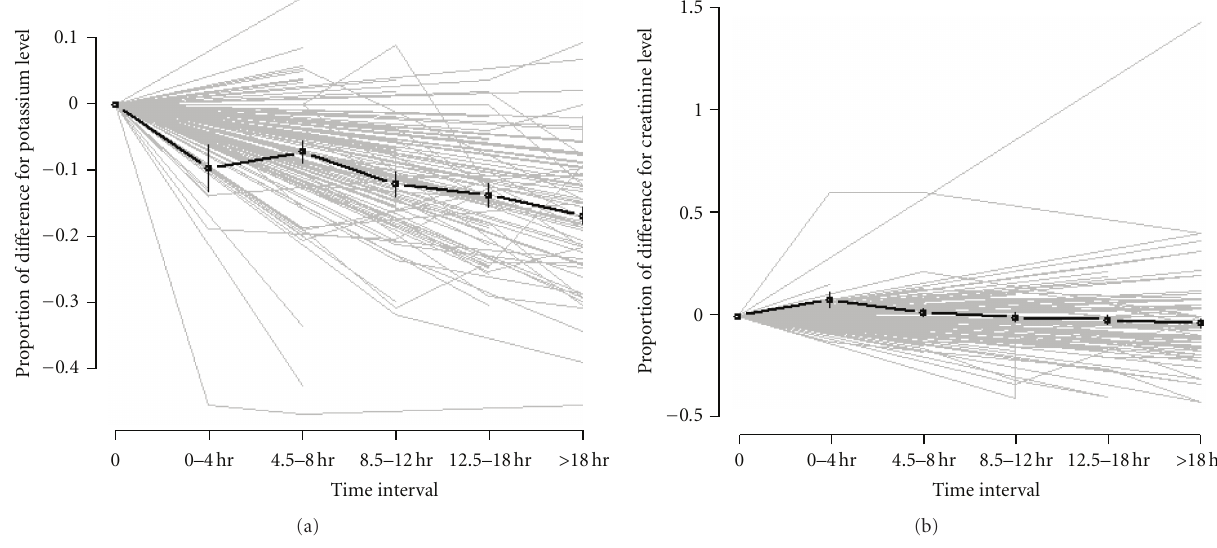
Figure 3: (a) Potassium versus time: proportion of change in serum potassium concentration [( K t − K 0 ) /K 0 ] was fitted by a linear mixed model with the time of repeat potassium measurement as the predictor variable. A statistically significant decrease was noted in the proportion of change of potassium for time intervals 0–4 hr, 4.5–8 hr, and 8.5–12 hr ( P value = 0.007, < 0.0001, < 0.0001, resp.). (b) Creatinine versus time: proportion of change in serum creatinine concentration [( C t − C 0 ) /C 0 ] was fitted by a linear mixed model with the time of repeat creatinine measurement as the predictor variable. No statistically significant di ff erence was noted in the proportion of change in creatinine in any of the time intervals (the K at t 0 will be referred to as K 0 and the follow-up K at time t will be referred to as K t . The C at t 0 will be referred to as C 0 and the follow up C at time t will be referred to as C t